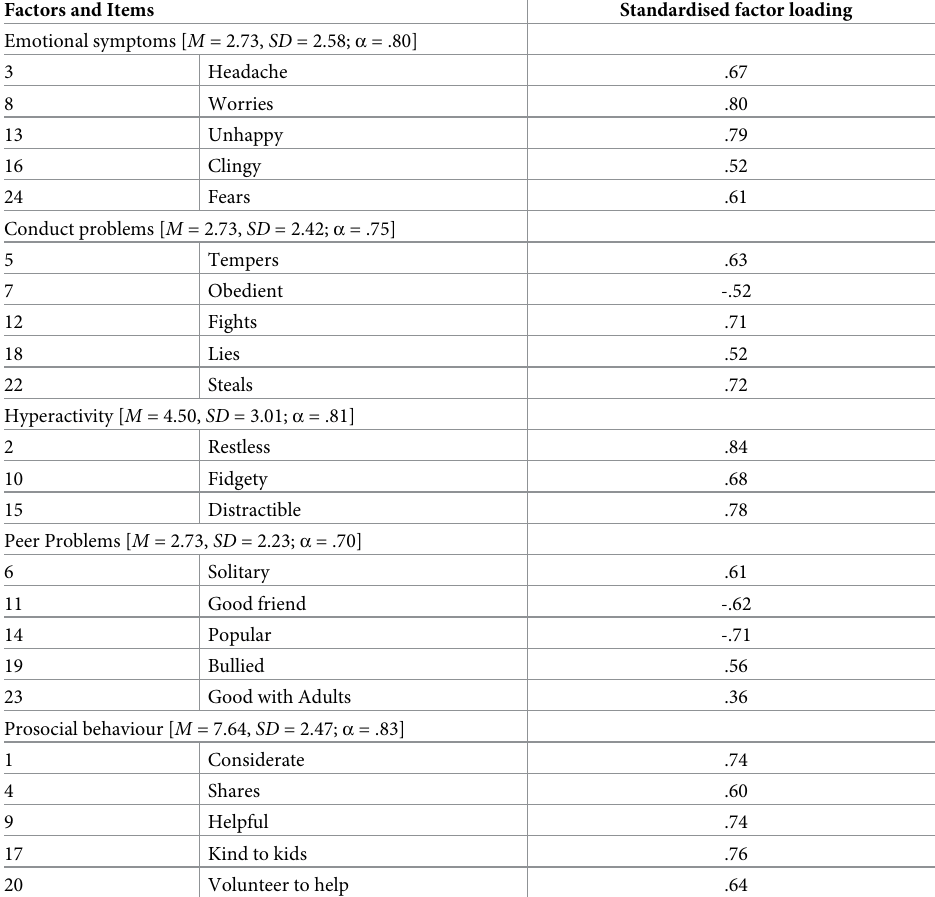
Table 2. SDQ items and factor descriptive statistics. Factors and Items Standardised factor loading Emotional symptoms [ M = 2.73, SD = 2.58; α =